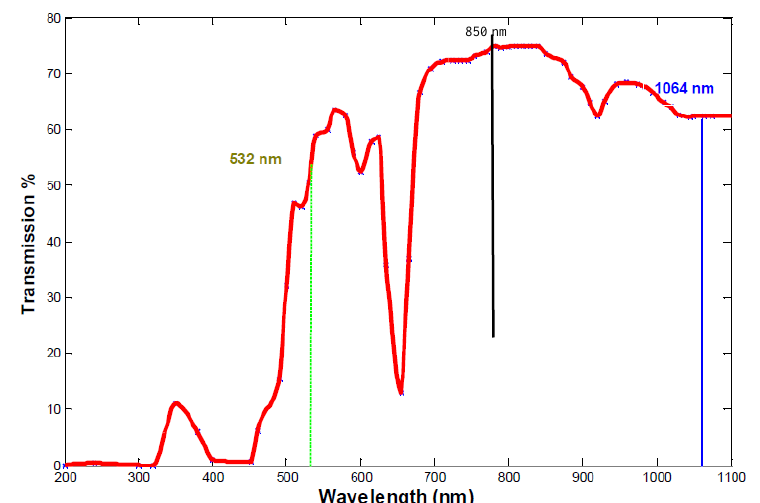
Figure 2. UV-VIS transmission of olive